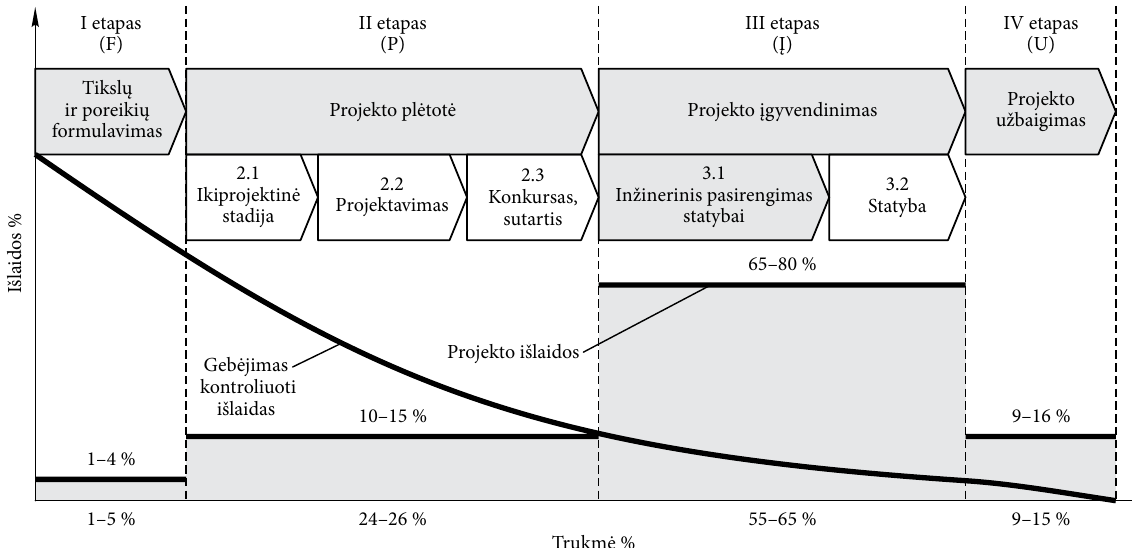
Fig. 1. Stages of a construction project. Variation in the accuracy of determining